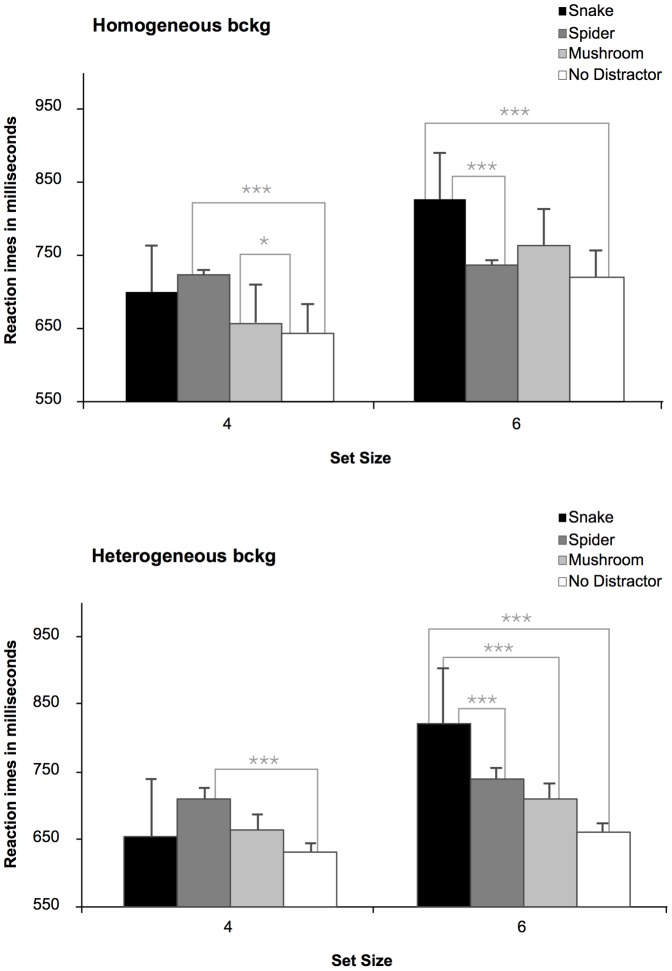
Mean Reaction Times (RTs) in milliseconds (ms) to locate a discrepant target (bird) in the different type of distractor conditions (snake, spider, mushroom, and no distractor), in Experiment 2.The upper panel refers to the homogeneous displays, whereas the lower panel illustrates the heterogeneous displays, both as a function of the set size (4; 6). Longer RTs indicate larger interference scores.